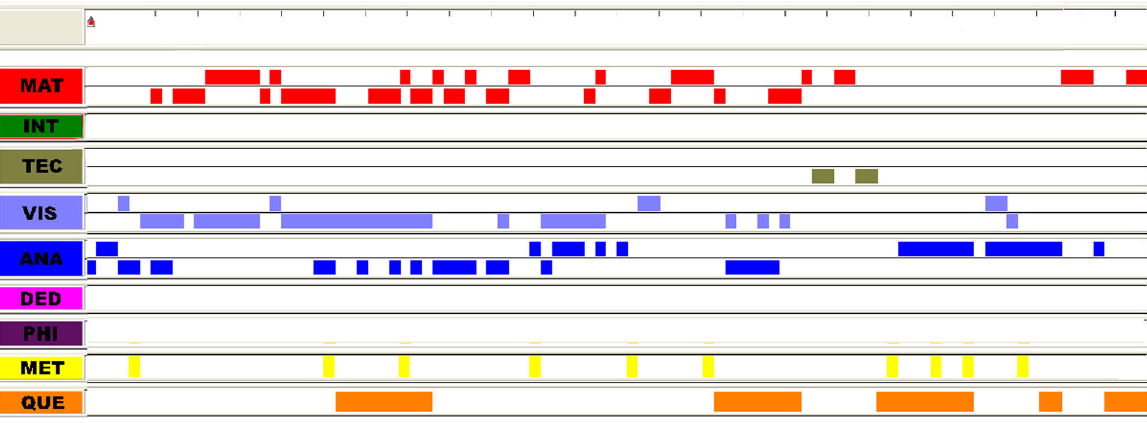
FIG. 2. Timeline of the flux